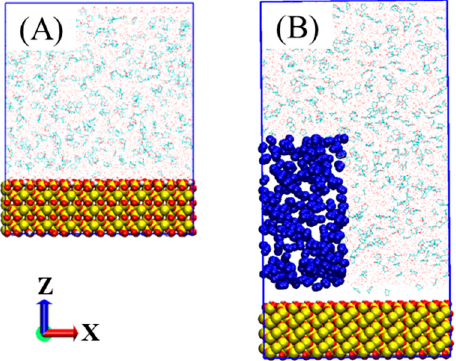
Figure 1. Models with ( B ) or without ( A ) the presence of a nitrogen bubble. The quartz plane is shown as balls (yellow for Si, red for O, and white for H), nitrogen atoms are represented as blue balls, THF and water molecules are described as lines (cyan for C, red for O, white for H).